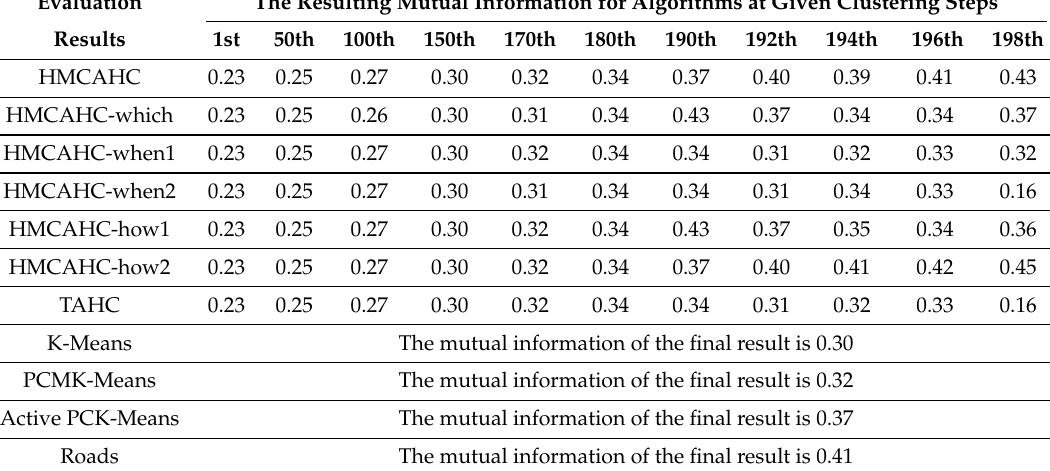
Table 3. Evaluation results for the LFW Data Set.